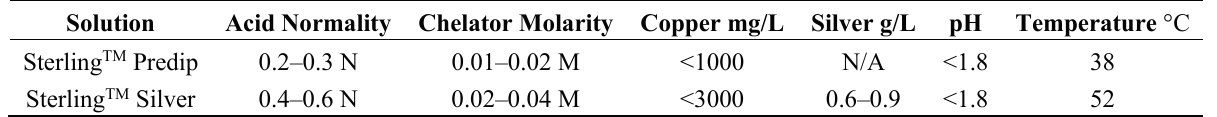
Table 1. MacDermid solution